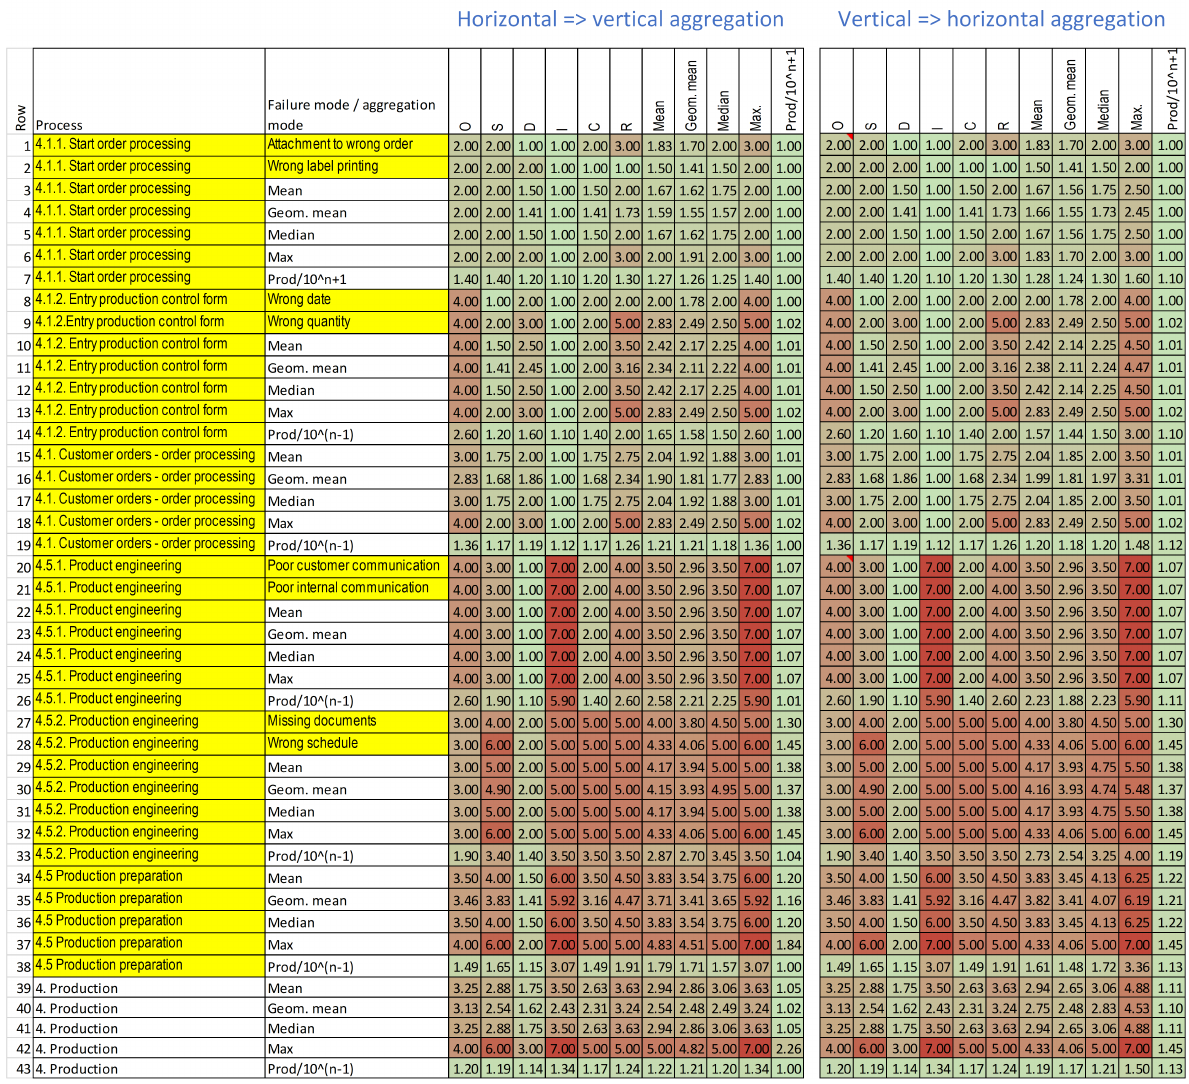
Figure 4. Risk-level matrix for production